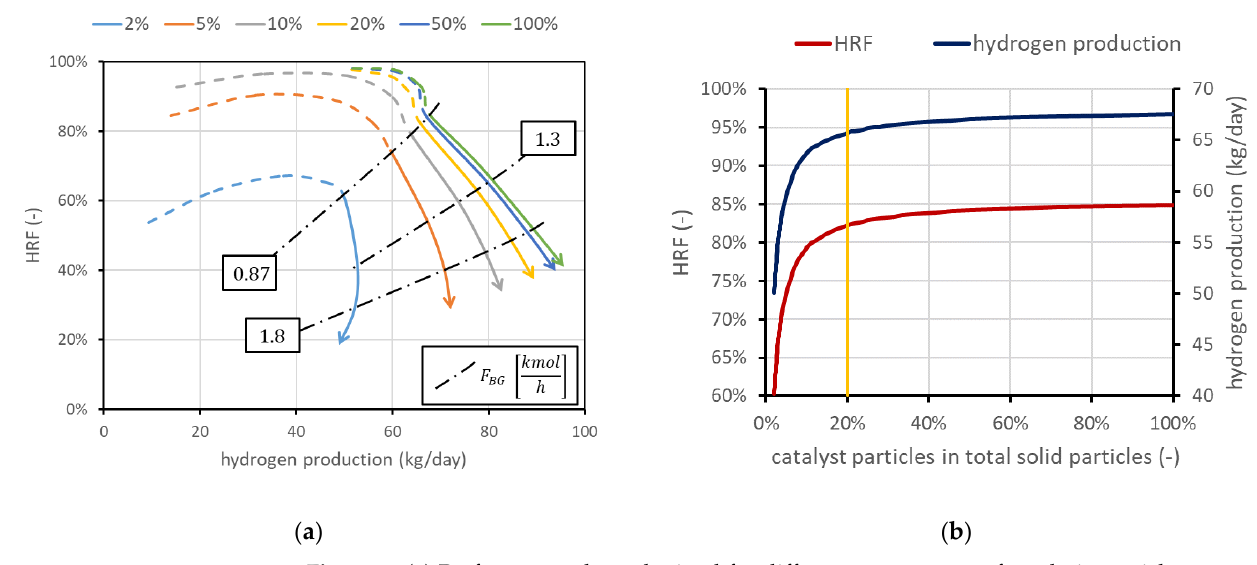
Figure 6. ( a ) Performance chart obtained for different percentages of catalytic particles over total solid particles in the reactor. Nominal value is 100% catalyst. ( b ) Impact of catalyst percentage in solid particles on HRF and hydrogen production for points at minimum u